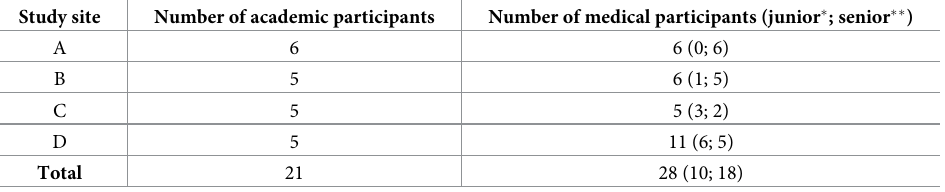
Table 2. Profile of study participants.